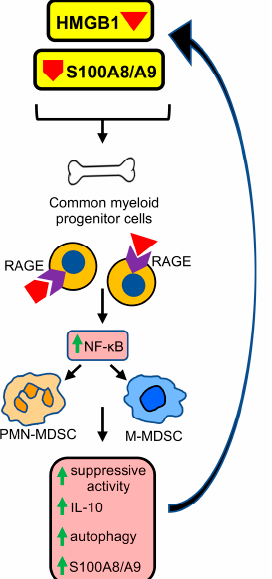
Figure 1. HMGB1 and S100A8/A9 induce the development of MDSCs from bone marrow progenitor cells. In healthy, non-stressed conditions, common myeloid progenitor cells (CMPs) in the bone marrow differentiate into dendritic cells, granulocytes (basophils, eosinophils, neutrophils), and macrophages. The tumor microenvironment (TME) or other stressful conditions induce damage associated molecular patterns (DAMPs) and alarmins HMGB1 and/or S100A8/A9, which bind to RAGE, and CMP differentiation is skewed toward the development of MDSCs. HMGB1 and S100A8/A9 binding activates NF-kB, resulting in increased suppressive potency, higher production of IL-10, a more autophagic state, and upregulation of S100A8/A9 by the MDSCs. The S100A8/A9 generated by MDSCs promotes the differentiation of additional CMPs into monocytic and polymorphonuclear MDSCs (M-MDSCs and PMN-MDSCs, respectively) via a feed-forward mechanism.